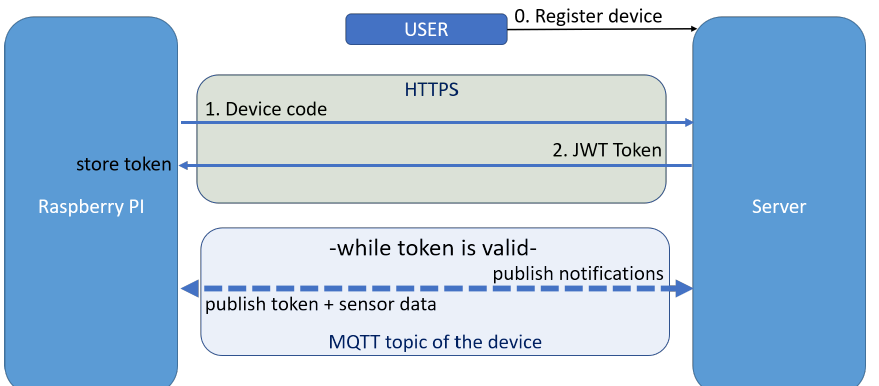
Figure 4. A representation of message handshake between the RPI and the server in the scope of authenticating the